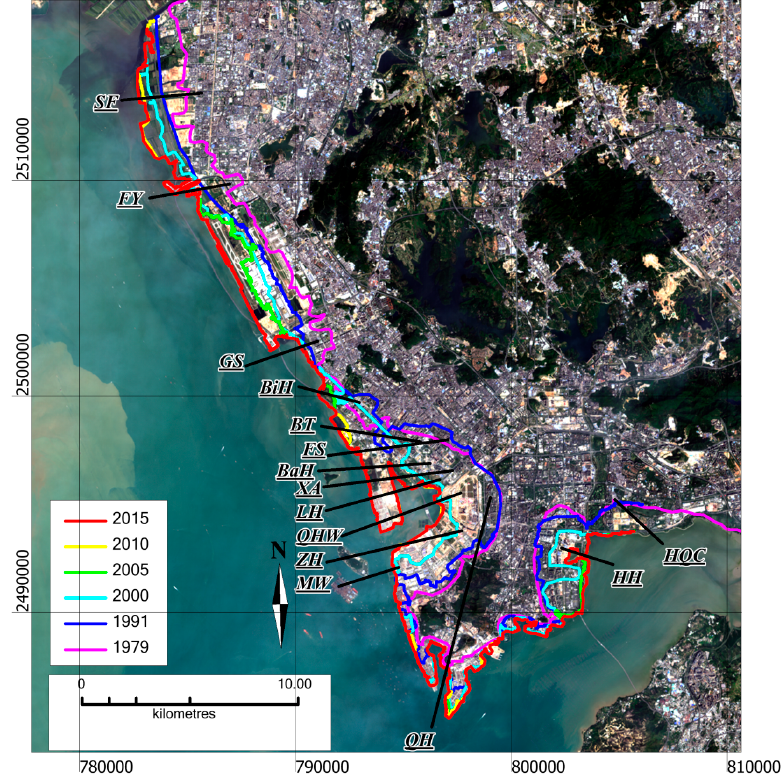
Figure 1. Shenzhen and its coastlines extracted from Landsat images in 1979, 1991, 2000, 2005, 2010 and 2015. Places shown on the map are Shafu (SF), Fuyong (FY), Gushu (GS), Bihai (BiH), Baoti (BT), Fanshen (FS), Baohua (BaH), Xin’an (XA), Linhai (LH), Qianhaiwan (QHW), Zhenhai (ZH), Mawan (MW), Qianhai (QH), Houhai (HH), and Huaqiaocheng (HQC).